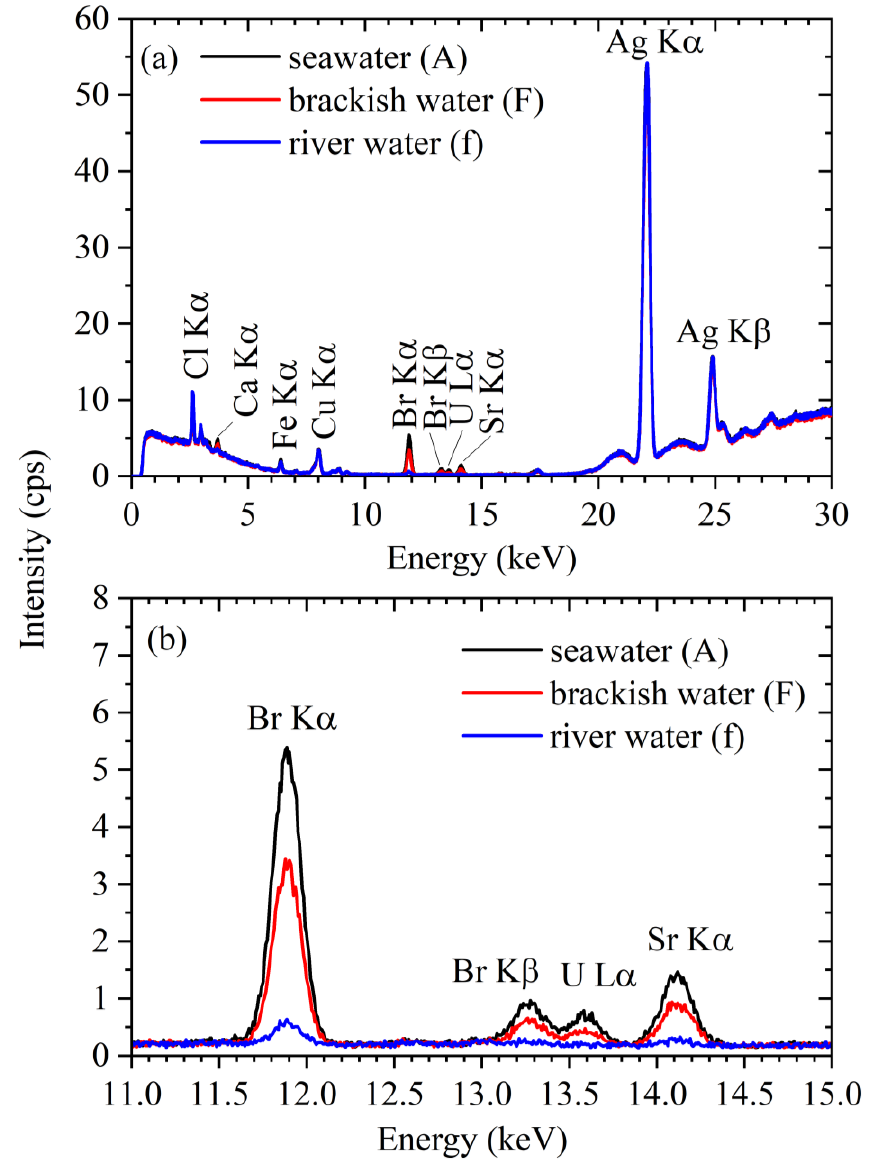
Figure 5. XRS spectra of the samples of river water (collected at point “A”), brackish water (collected at point “F”), and seawater (collected at point “f”). ( a ) The whole spectra; ( b ) an enlarged view.